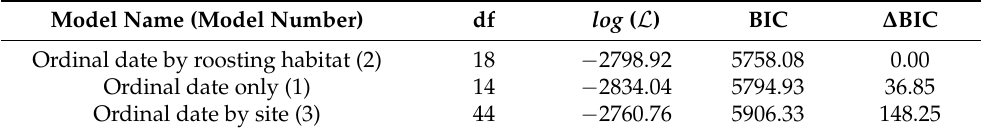
Table 3. A priori models ranked by Bayesian information criterion (BIC) from acoustic data collected off the Eastern Shore of Virginia, USA, 2012–2019. Displayed are the model names and numbers as referenced in Table 1, approximate degrees of freedom, − log (Likelihood), BIC, and ∆ BIC.